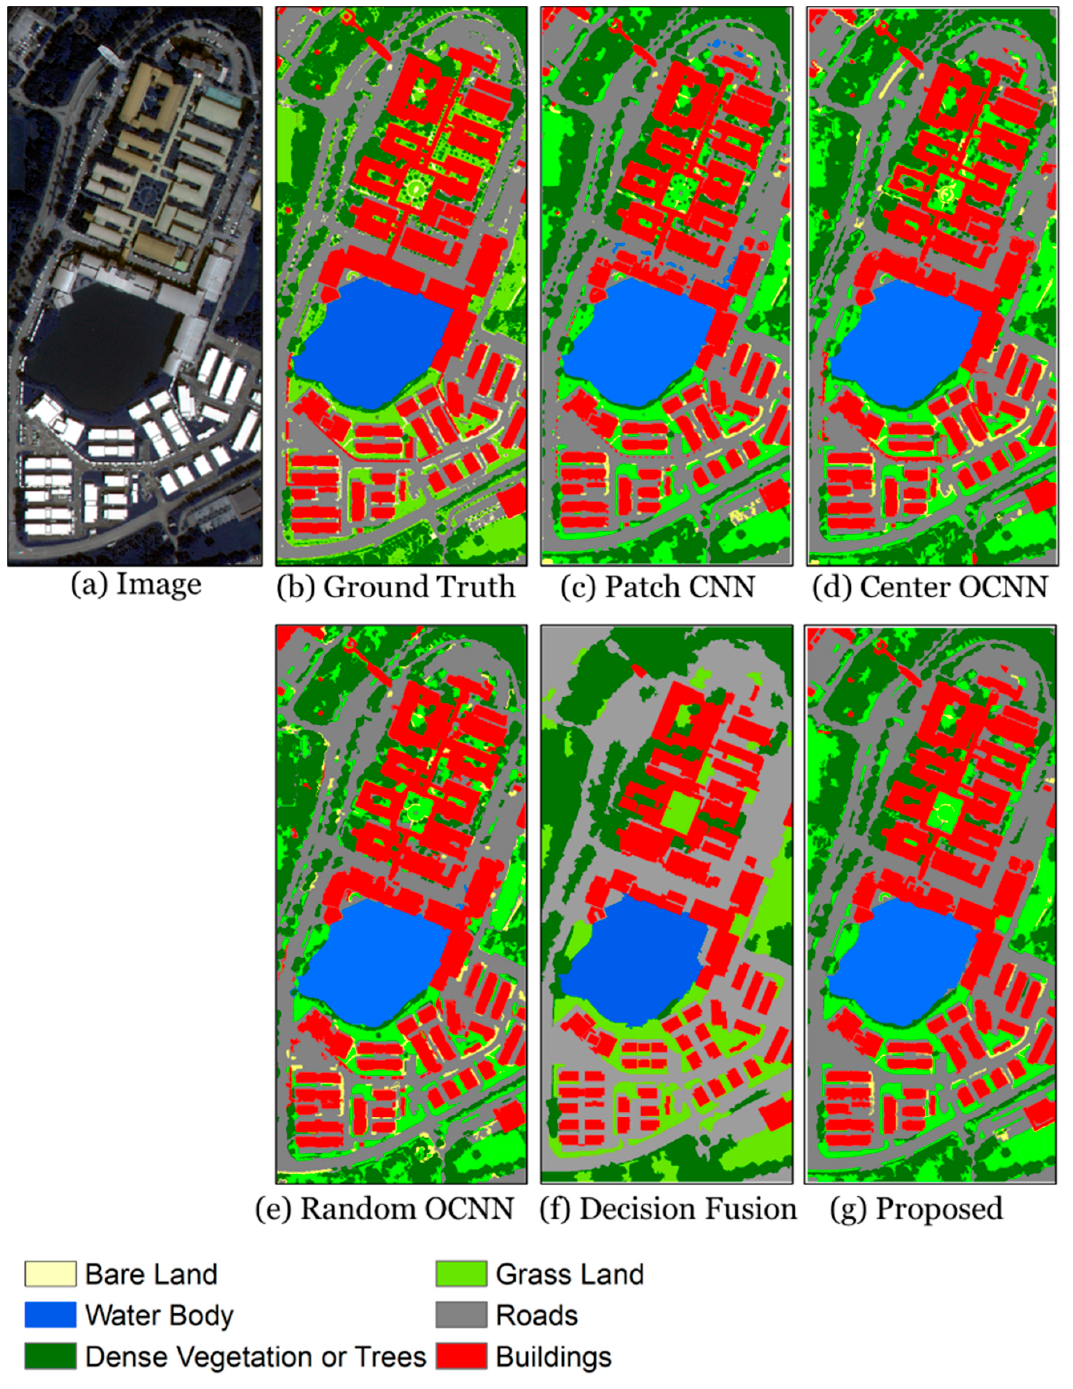
Figure 11. Classification maps of different methods used in this research for the test area. The accuracy of classification maps was measured by OA, Kappa, and mIoU at the pixel level. Tables 5 and 6 summarize the measured accuracies for different methods in training and testing areas. The Patch CNN achieved the worst accuracy of 0.89 OA and Kappa and 0.86 mIoU in the training area and slightly better accuracy in the test area of 0.93 OA and Kappa and 0.91 mIoU. The Decision-Fusion method performed almost the same as the Patch CNN. The methods that rely on context patches show that the Center OCNN achieved better classification accuracy than the Random OCNN in both the training and test areas. For example, based on mIoU, the Center OCNN achieved 0.93 compared